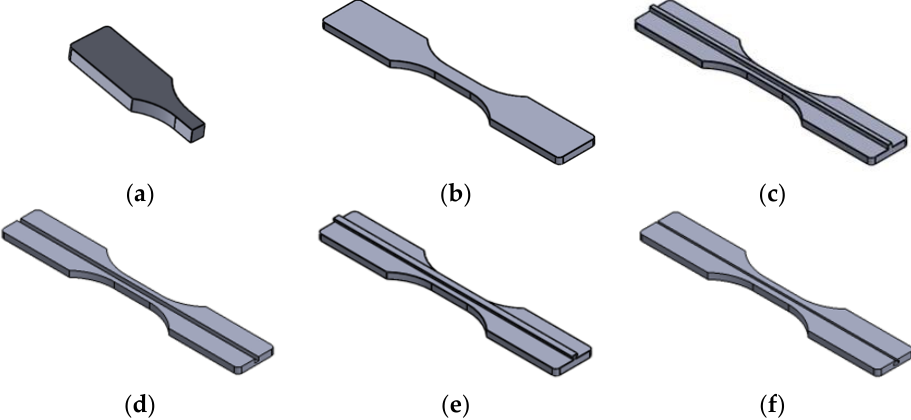
Figure 1. CAD Design for FDM inserts: ( a ) half-length; ( b ) half-thickness; ( c ) half-thickness male cube; ( d ) half-thickness female cube; ( e ) half-thickness male T; ( f ) half-thickness female